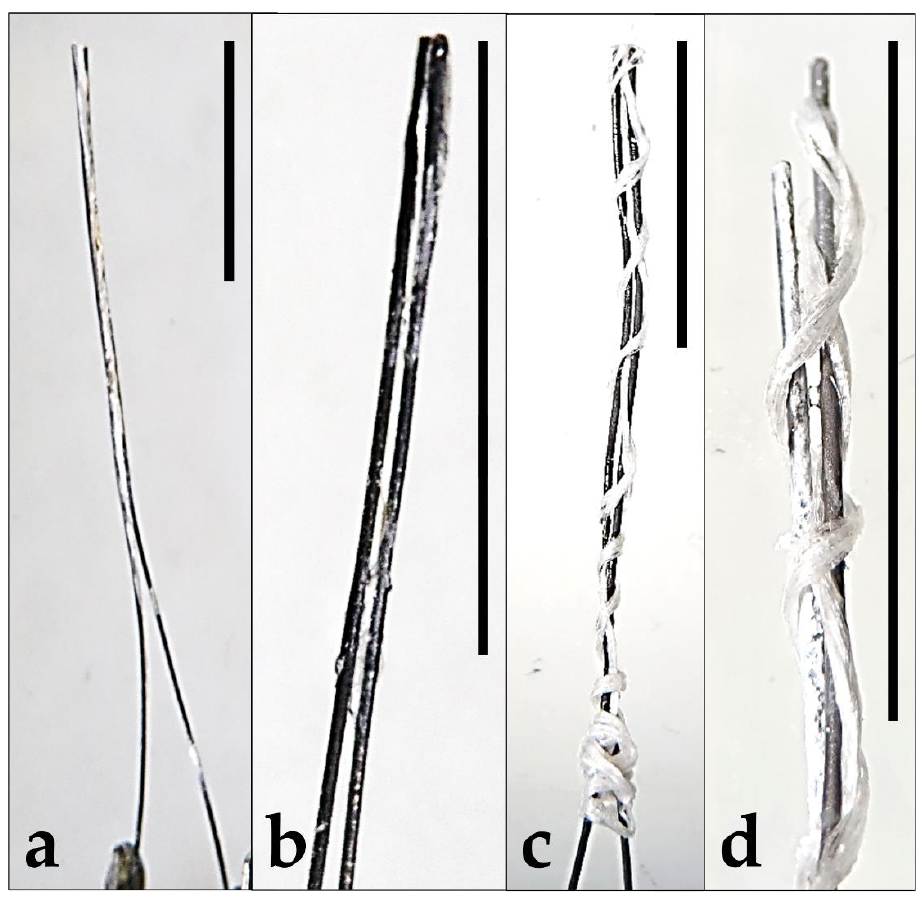
Figure 1. BDD electrodes used for initiation of precipitation. ( a , b ) Glued wire electrode (this work); ( c , d ) wound wire electrode. Scale bars represent 1 cm.